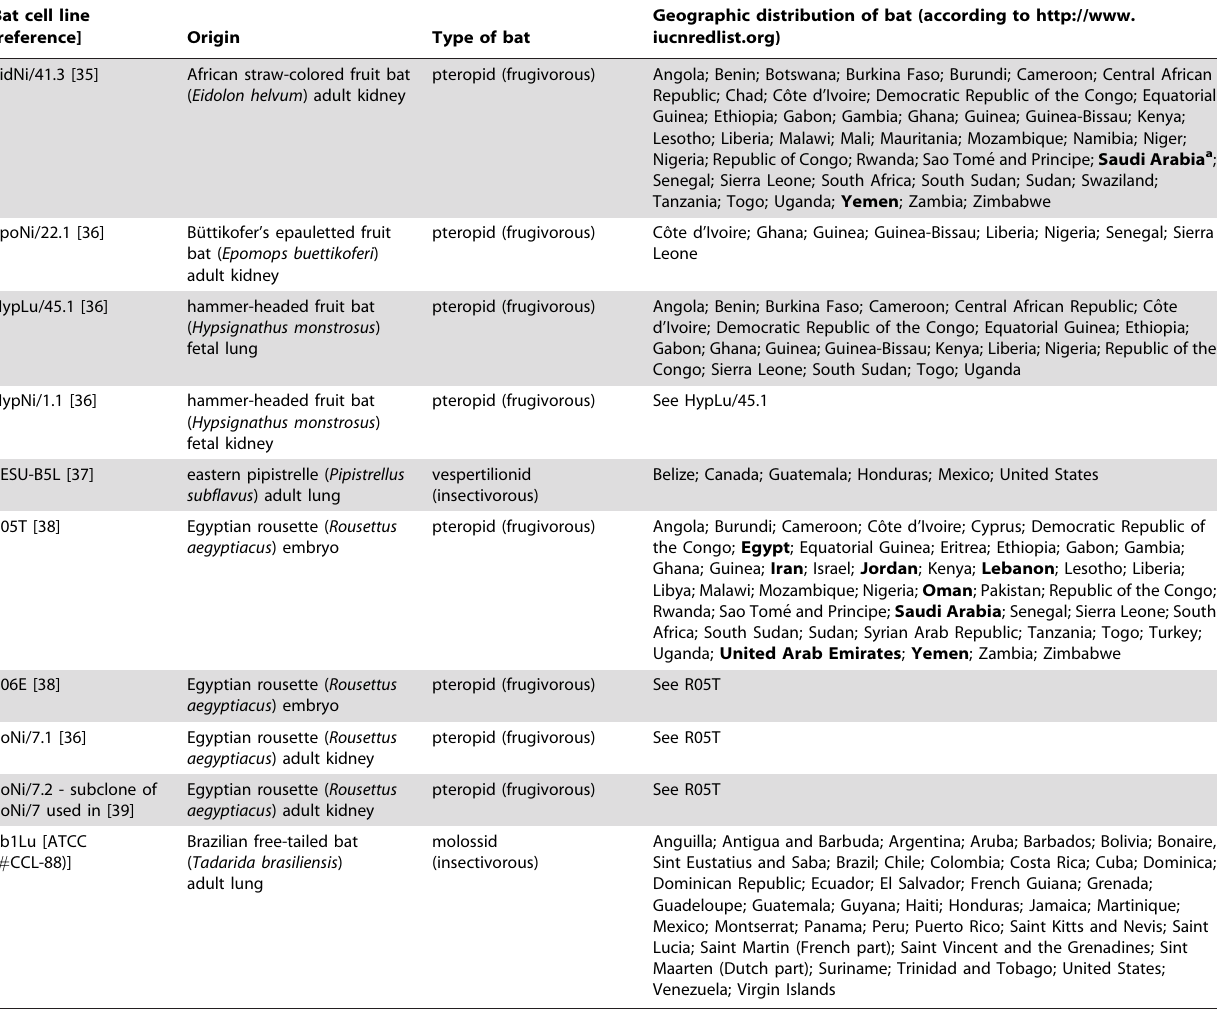
Table 1. Origin of tested bat cell